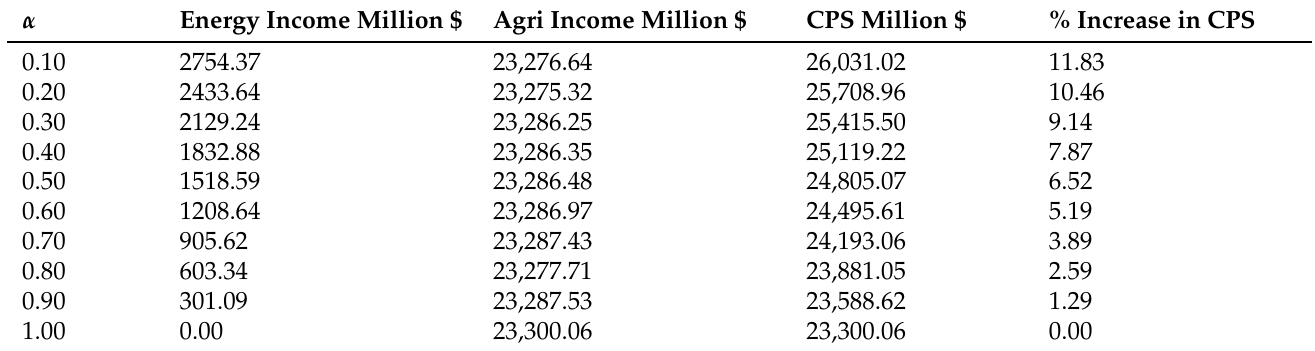
Table 3. Impact of hydropower on basin wide income with 50% exceedance probability.